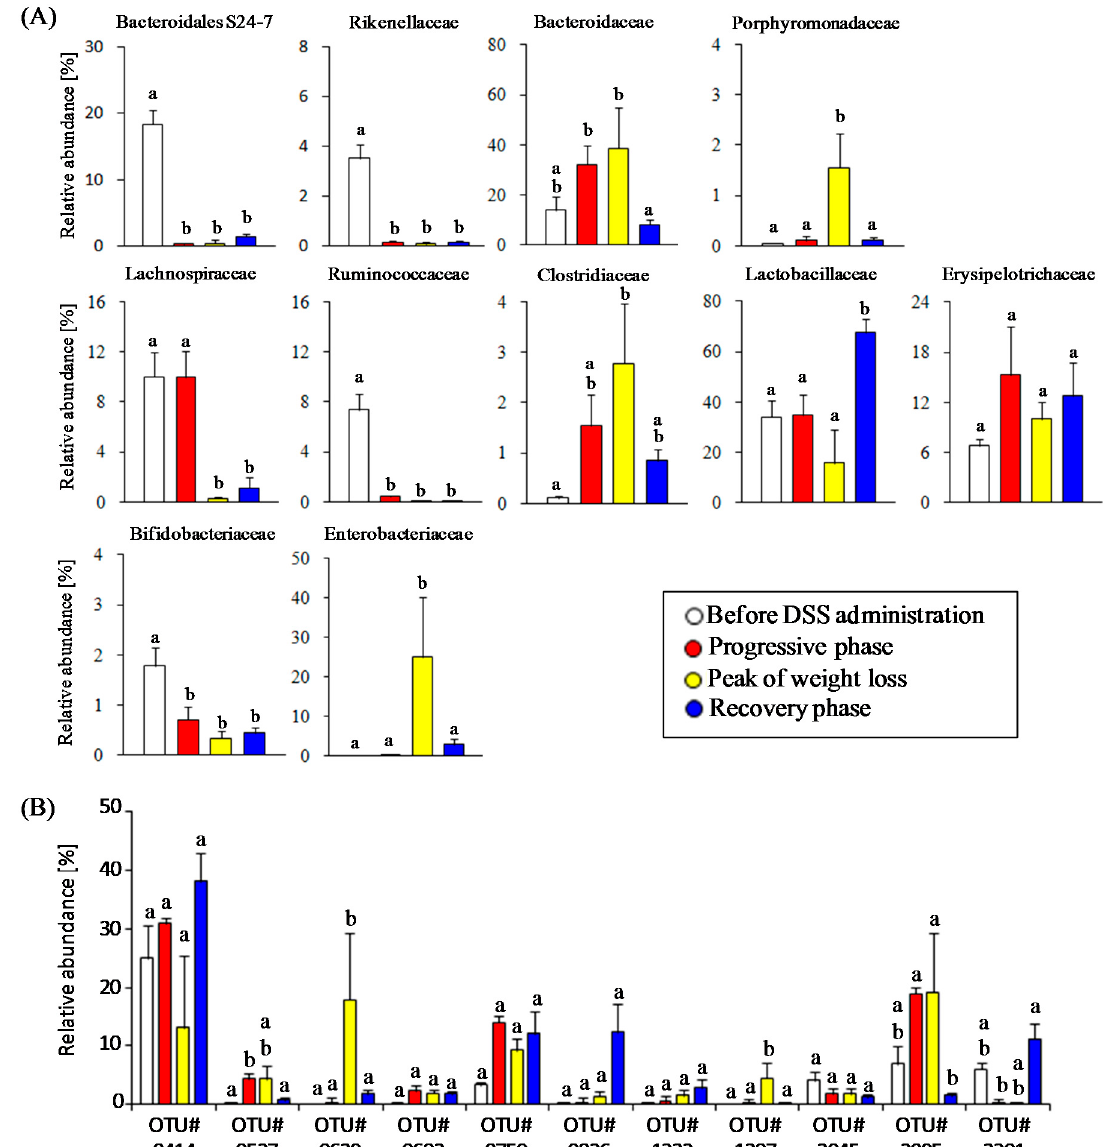
Figure 3. Characteristics of changes in relative abundances of major commensal bacterial groups. ( A ) Changes in the abundances of eleven bacterial families in four pathological phases; ( B ) Changes of the top five most abundant operational taxonomic units (OTUs) in each phase. Different letters indicate significant differences between bars.